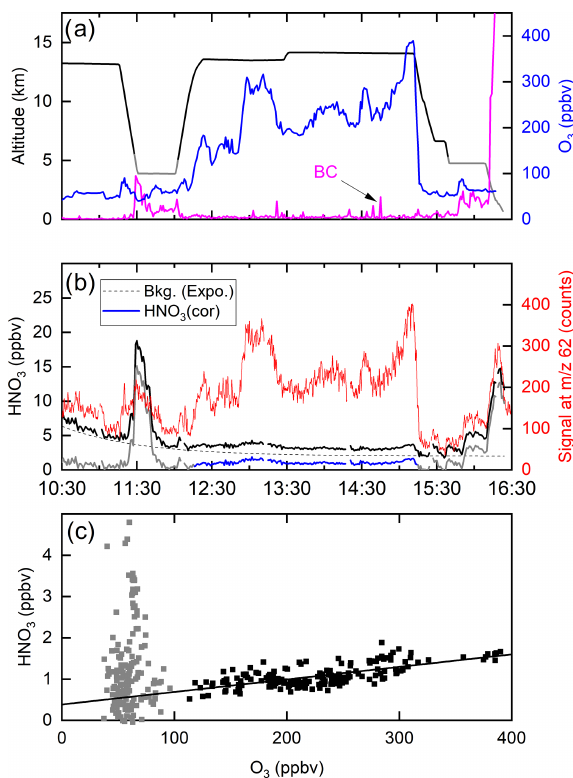
Figure 10. (a) Altitude (black) and O 3 mixing ratios (blue) from a HALO flight during the CAFE-Africa campaign. The purple line (arbitrary units) is proportional to the black-carbon particle number density (BC). (b) The signal at m/z 62 (red line) clearly co-varies with O 3 . Following conversion to a mixing ratio (black line) and subtraction of an HNO 3 background signal (dotted line, assuming an exponential decay) originating in the 210 Po source, the solid blue line for HNO 3 is obtained (HNO 3 cor). (c) HNO 3 mixing ratios plotted versus O 3 mixing ratios. The straight black line has a slope of ( 3 ± 0 . 5 ) × 10 − 3 and does not take into account the grey data points (O 3 mixing ratio <